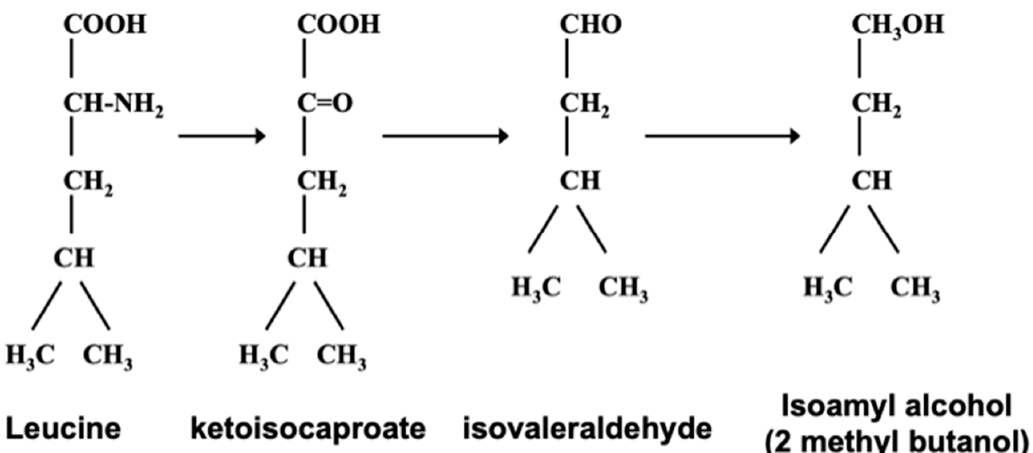
Figure 3. Ehrlich pathway, relationship between higher (fusel) alcohols and amino acids.